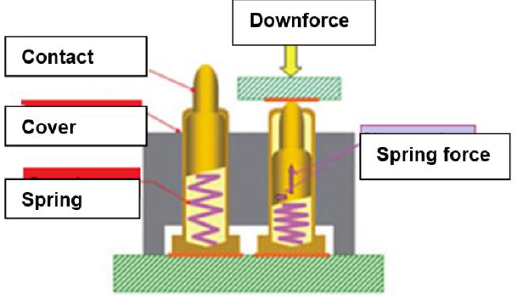
Figure 3. Schematic structure of the electrodes to measure the resistance of textiles.